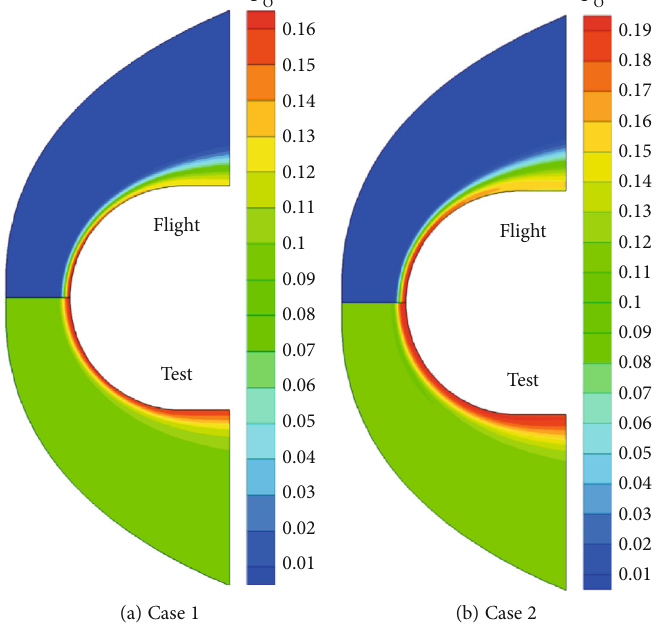
Figure 14: Comparison of the oxygen atom mass fraction on the symmetric